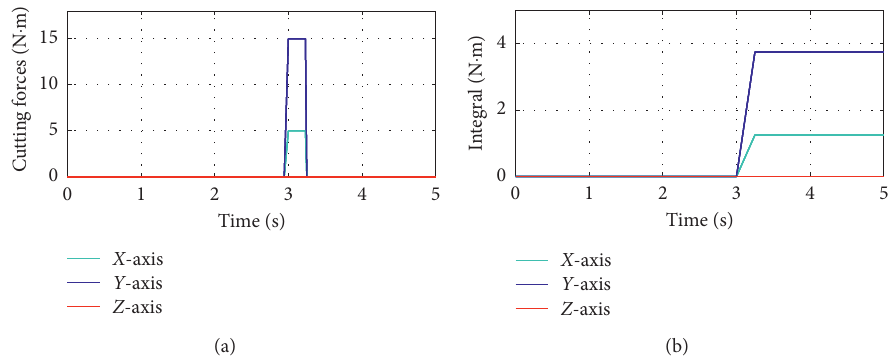
Figure 7: The disturbances from cutting forces along three axes. (a) Pulse disturbances from cutting forces. (b) Integral of the disturbances.